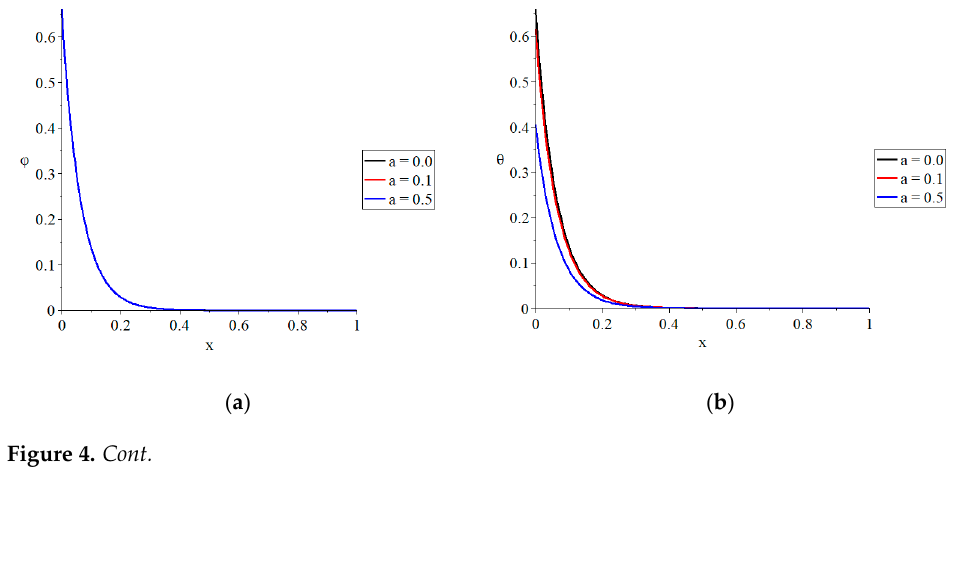
Figure 3. The distributions with variance ramp-type heat parameter when β = 1.0, a = 0.1. ( a ) The distribution of conductive temperature, ( b ) the distribution of dynamical temperature, ( c ) the distribution of lateral deflection, ( d ) the distribution of strain, ( e ) the distribution of stress, ( f ) the distribution of strain energy density function.